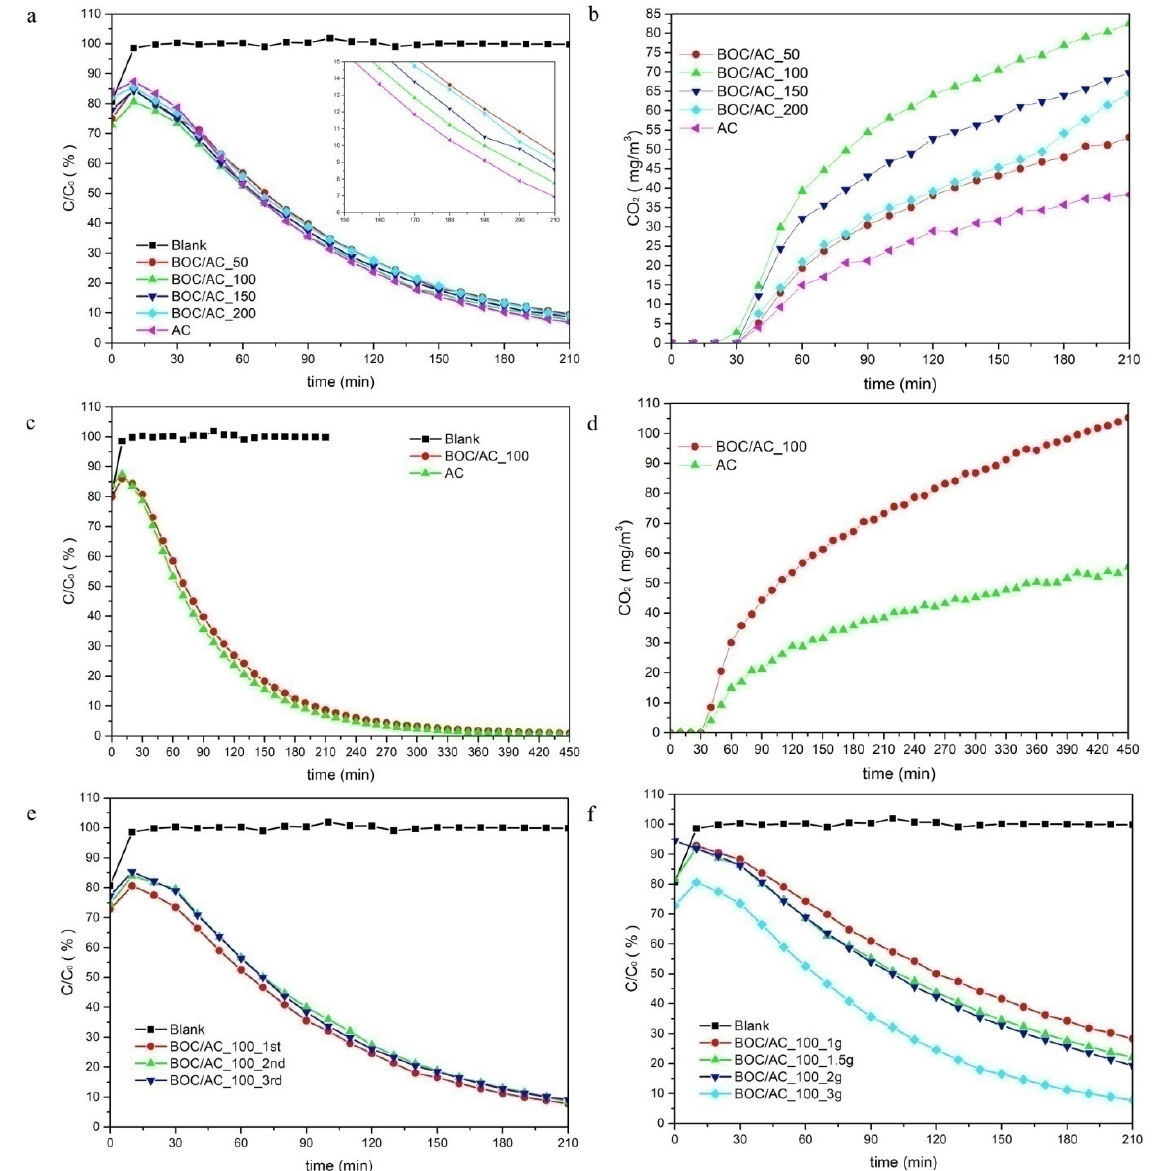
Figure 8. The photocatalytic performance of the BOC/AC samples for toluene removal in air ( a ), theCO 2 productivity of the samples ( b ), the property of BOC/AC_100 and AC for toluene removal ( c ), CO 2 productivity of BOC/AC_100 and AC ( d ), the stability of BOC/AC_100 for three cycles ( e ), and the toluene removal efficiency of the different amounts of BOC/AC_100 ( f ).